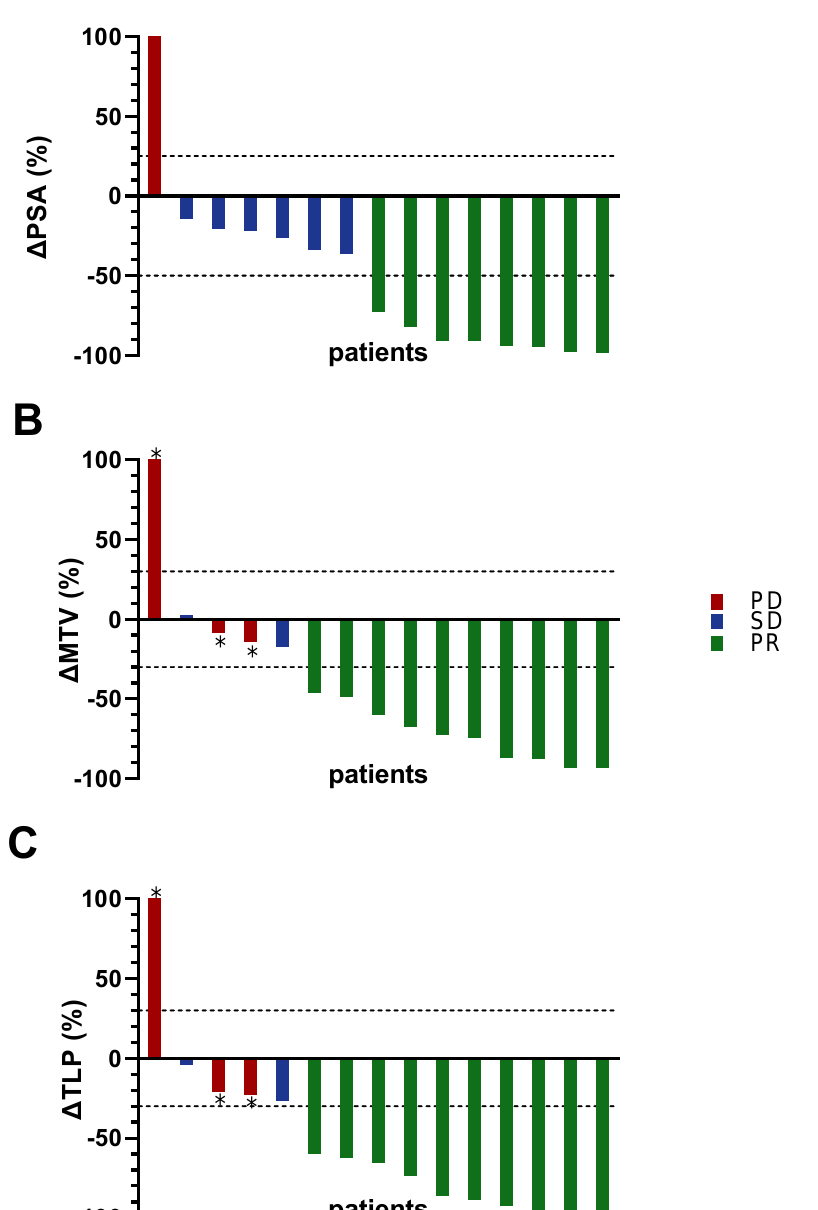
Figure 1. Waterfall plots of individual changes in ( A ): PSA serum value; ( B ): MTV; ( C ): TLP. Red: progressive disease (PD). Blue: stable disease (SD). Green: partial remission (PR). * Appearance of new